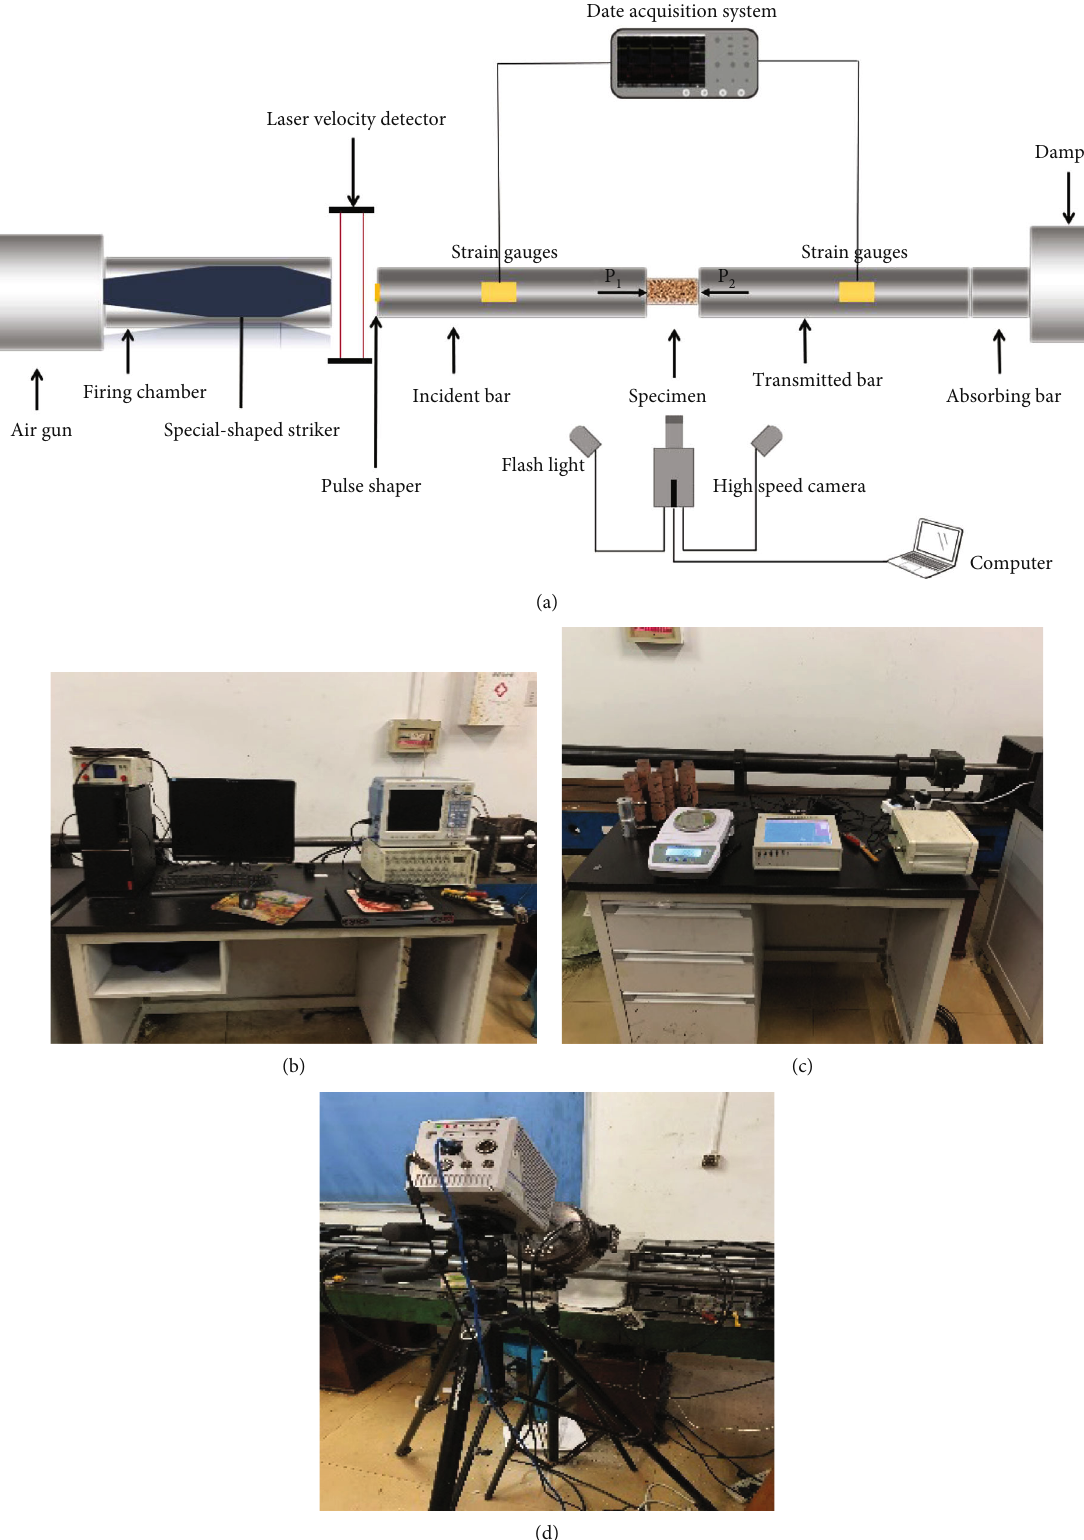
Figure 2: SHPB system and test equipment. (a) SHPB system, (b) data acquisition system, (c) electronic scale and wave velocity meter, (d) high-speed